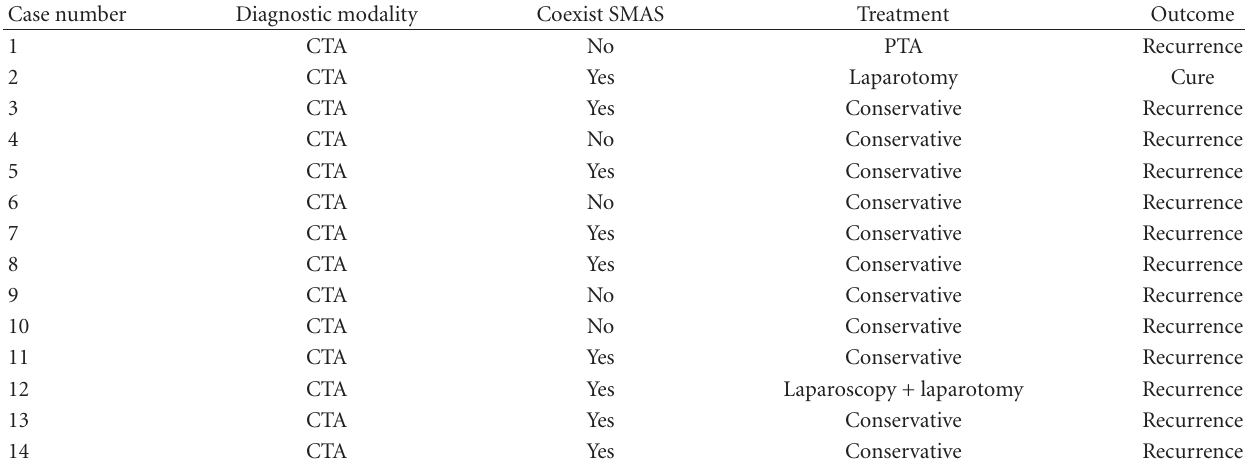
Table 2: The diagnosis modalities, treatments, and outcomes of patients with celiac artery compression syndrome ( n = 14). Case